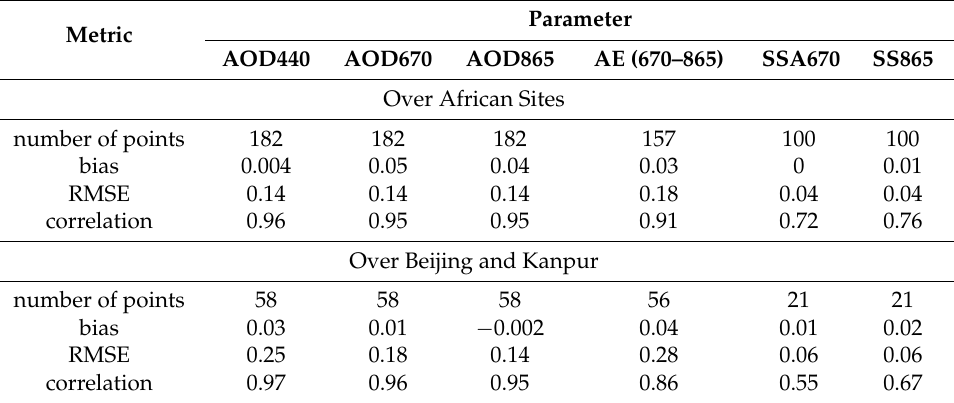
Table 11. Comparison of GRASP/PARASOL AOD at different wavelengths, Ångström exponent (AE) and single scattering albedo (SSA) vs. AERONET over sites in Africa (Mongu, Banizoumbou, IER_Cinzana, Agoufou, Ilorin) and over Beijing and Kanpur for 2008. Values are covering high extremes (AOD: 0–4, AE: 0–2.5, SSA: